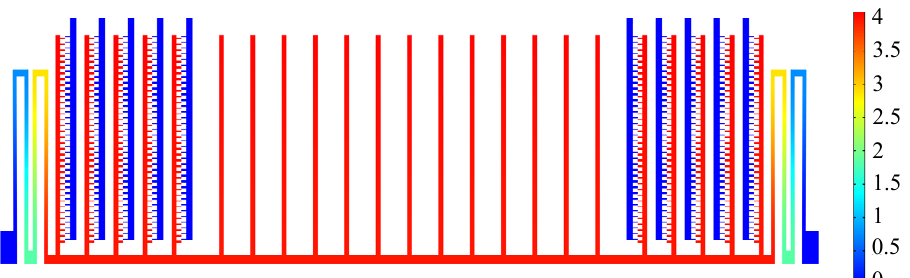
Figure 12. Displacement field distribution of the MEMS sensor.